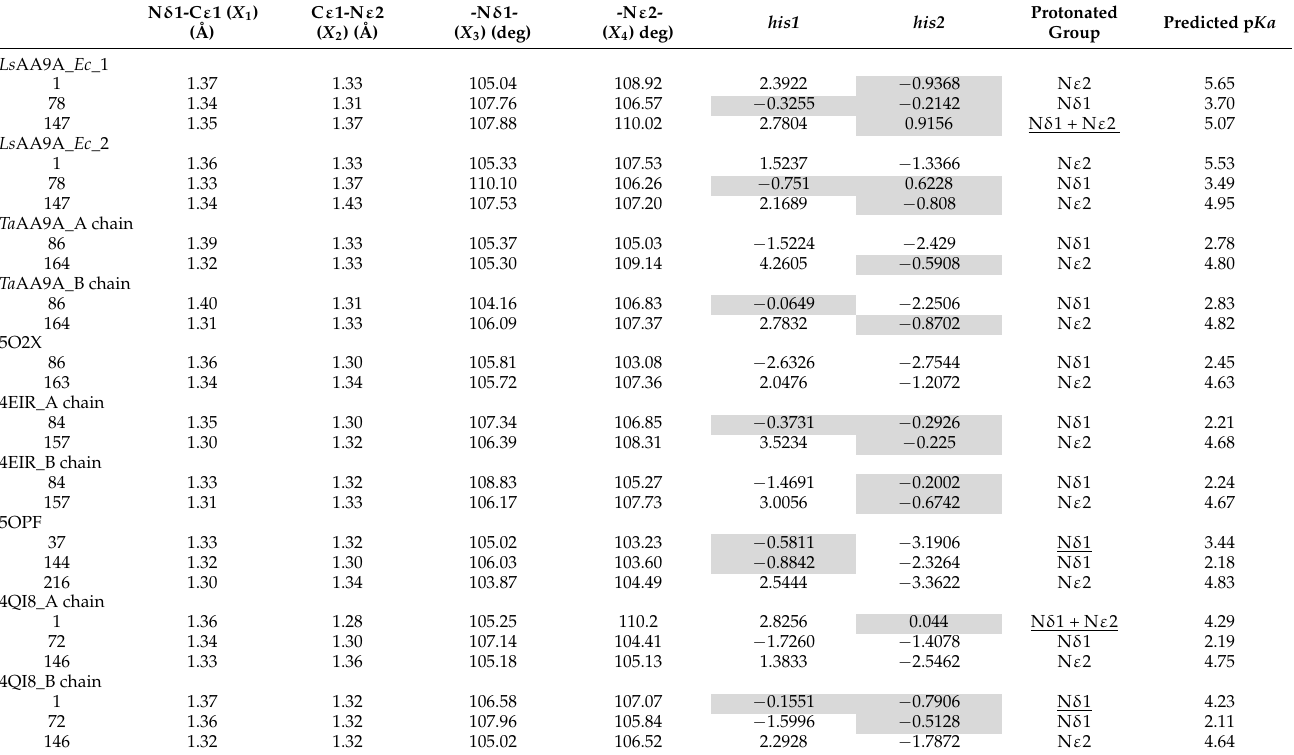
Table 3. Geometrical parameters and estimation of protonation state after His-only unrestrained refinement. The PROPKA predicted p Ka values for these histidine residues are also given in the last column. These p Ka values denotes the transition of the His imidazole ring from doubly protonated, positively charged state to singly protonated neutral form. The grey boxes represent values of his1 or his2 between +1 and − 1, and thus with low confidence in predicting the protonation states. For each structure, the first two (or one in some cases) represent the active site His residues and the last residue represents the 2nd coordination sphere